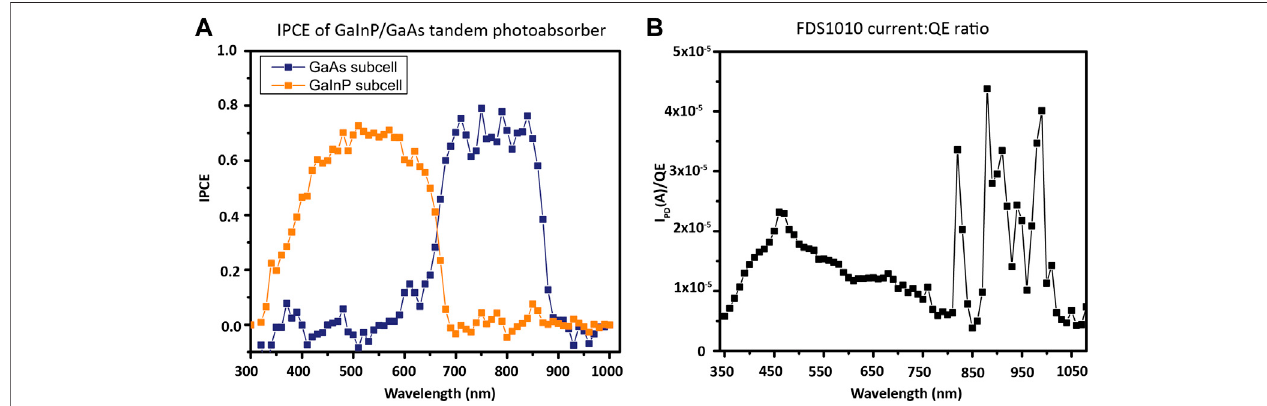
FIGURE 12 | IPCE calculation. (A) Two-electrode, 0 V bias, IPCE of GaInP/GaAs photocathode, acquired with 1 mW bias light illuminating the junction not being measured. (B) Calibrated photodiode photocurrent:QE ratio. Because the calibration of FDS1010 is done from 350 to 1050 nm, the x -axis between the two samples differs